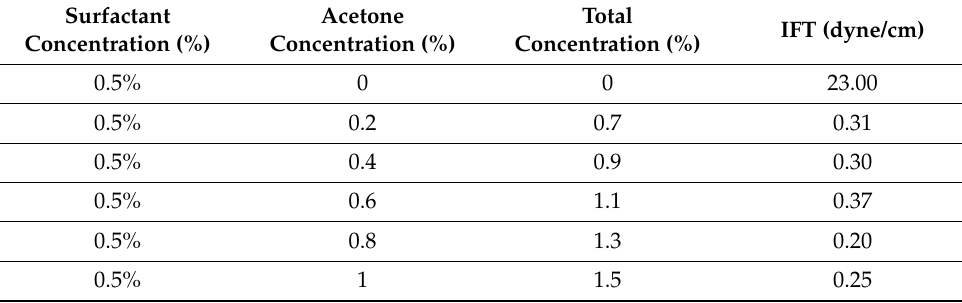
Table A8. IFT Values for Different Surfactant Concentrations.